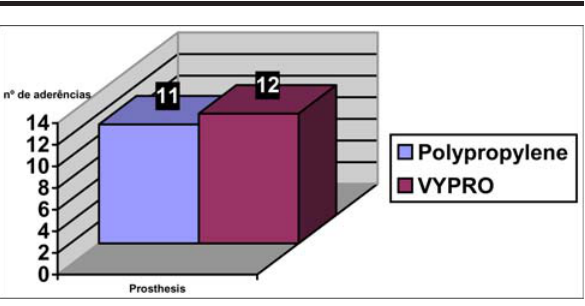
FIGURE 3 - Comparison between polypropylene and Vypro mesh concerning amount of adhesions formation.